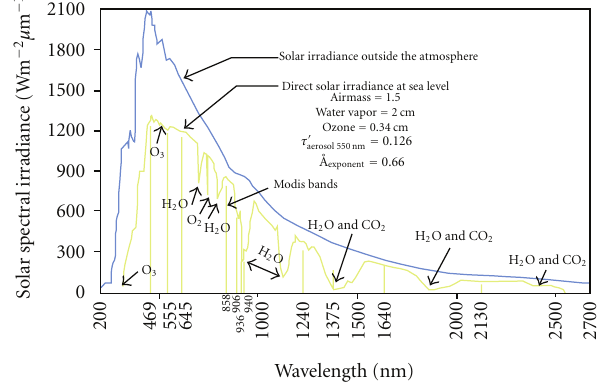
Figure 10: Spectrum of solar irradiance outside the atmosphere and at the sea level with absorption of electromagnetic waves by atmospheric gases. Visible light is 0.4–0.8 μ (400–800